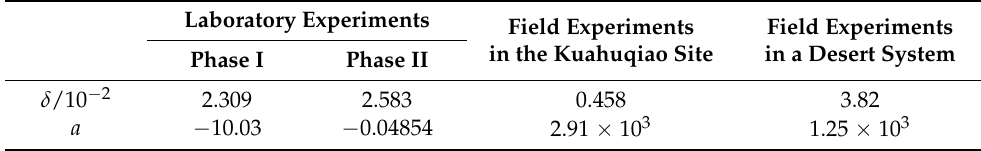
Table 3. Values of fitting parameters used for different